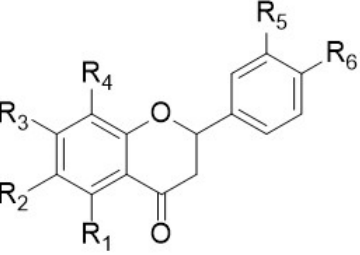
Figure 3. Chemical structure of polymethoxyflavanones. Table 12. Chemical structure of polymethoxyflavanones ( 72-77 ) isolated in genus Citrus.